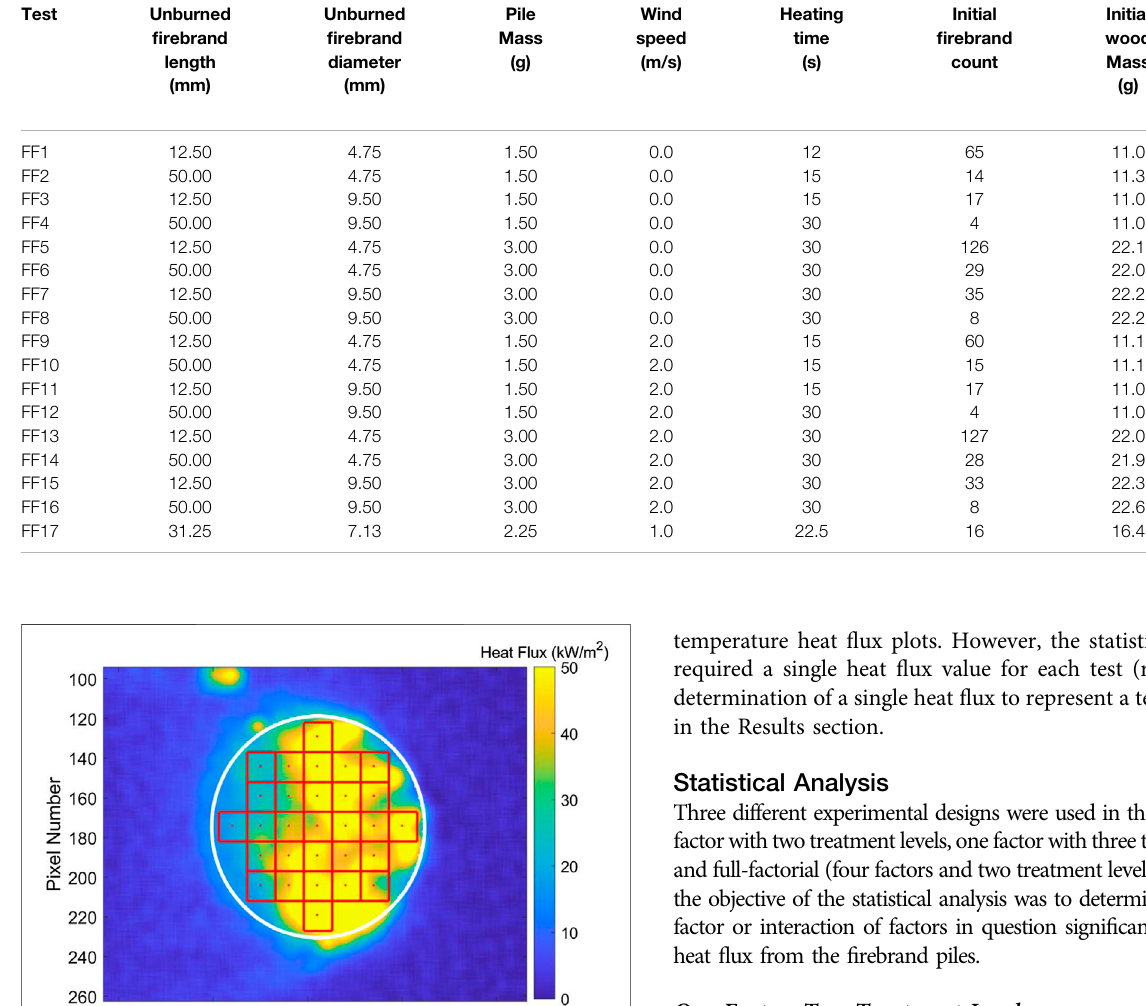
TABLE 6 | Full-factorial test matrix used to assess the effect of unburned fi rebrand length and diameter, pile mass, and wind speed on the heat transfer from fi rebrand piles from live N. Red Oak branches. Test